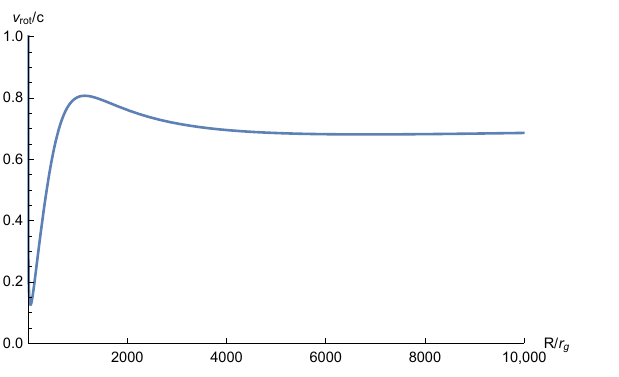
Figure 3. The general form of a model rotational curve for the eicheon parameters specified in the caption to Figure